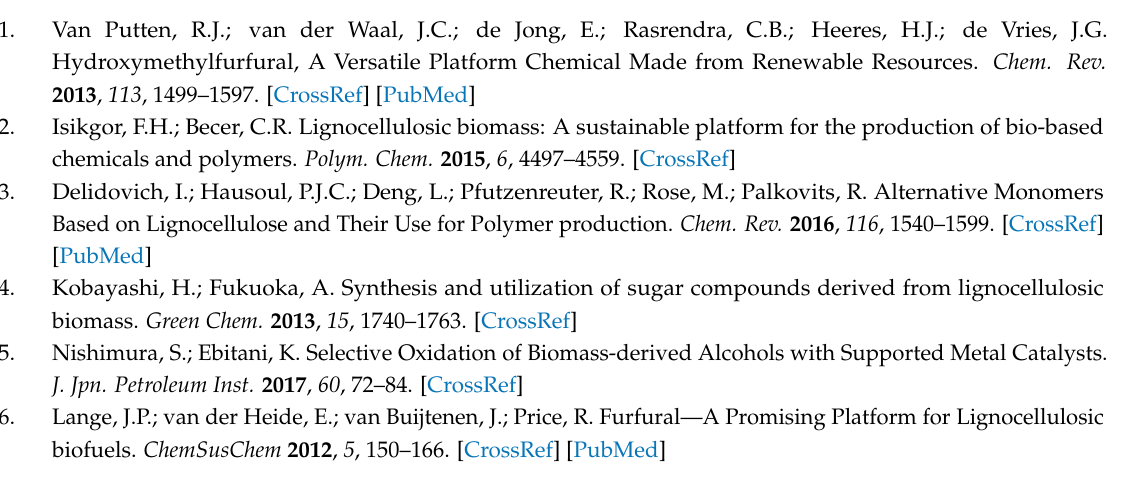
s1, Figure S1: Pore size distributions of ZSM-5, mordenite, zeolite Y, and normal SiO 2 -Al 2 O 3 determined by Ar adsorption, Figure S2: Pore size distributions of zeolite beta with various SiO 2 /Al 2 O 3 determined by Ar adsorption, Figure S3: Time-based reaction progression of furfural conversion for hydroxymethylation among four zeolites and normal SiO 2 -Al 2 O 3 in a batch reactor, Table S1: Recycling experiments for the zeolite beta (SiO 2 /Al 2 O 3 = 150) in a batch reactor, Figure S4: T Photographs of (a) fresh and (b) spent zeolite beta catalyst (SiO 2 /Al 2 O 3 = 150), Figure S5: TG-DTA curves of spent zeolite beta (SiO 2 /Al 2 O 3 = 150) in a batch reaction, Figure S6: Example of HPLC chromatograph for the hydroxymethylation of furfural to HMF in aqueous formaldehyde over zeolite beta, Figure S7: Time-based reaction progression of the hydroxymethylation of furfural to HMF among zeolite beta samples composed of different SiO 2 /Al 2 O 3 ratios in a batch reactor: (a) furfural conversion and (b) HMF yield, Figure S8: Time-based reaction for HMF production in a flow reactor using f zeolite beta samples composed of various SiO 2 /Al 2 O 3 ratios: (a) furfural conversion and (b) HMF